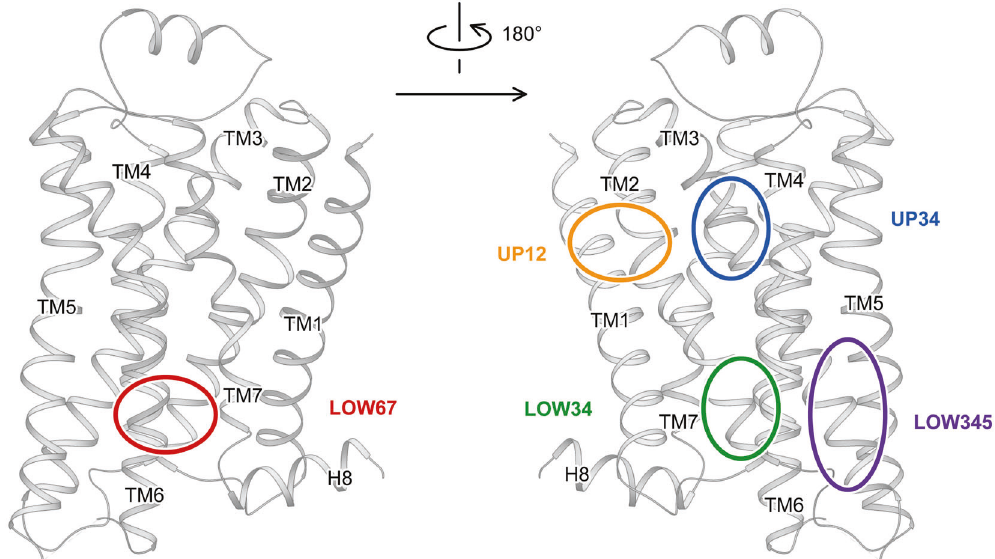
Fig. 9 Schematic diagram of allosteric sites at the lipidic surface identi fi ed by complex structures. The binding sites are manually labeled on the crystal structure of β 2 AR (PDB code: 6OBA 180 ). Solid line, allosteric site at front side; dashed line, allosteric site at back side. UP, upper part aka close to the extracellular end; LOW, lower part aka close to the cytoplasmic end; numbers, main interacting transmembrane helices